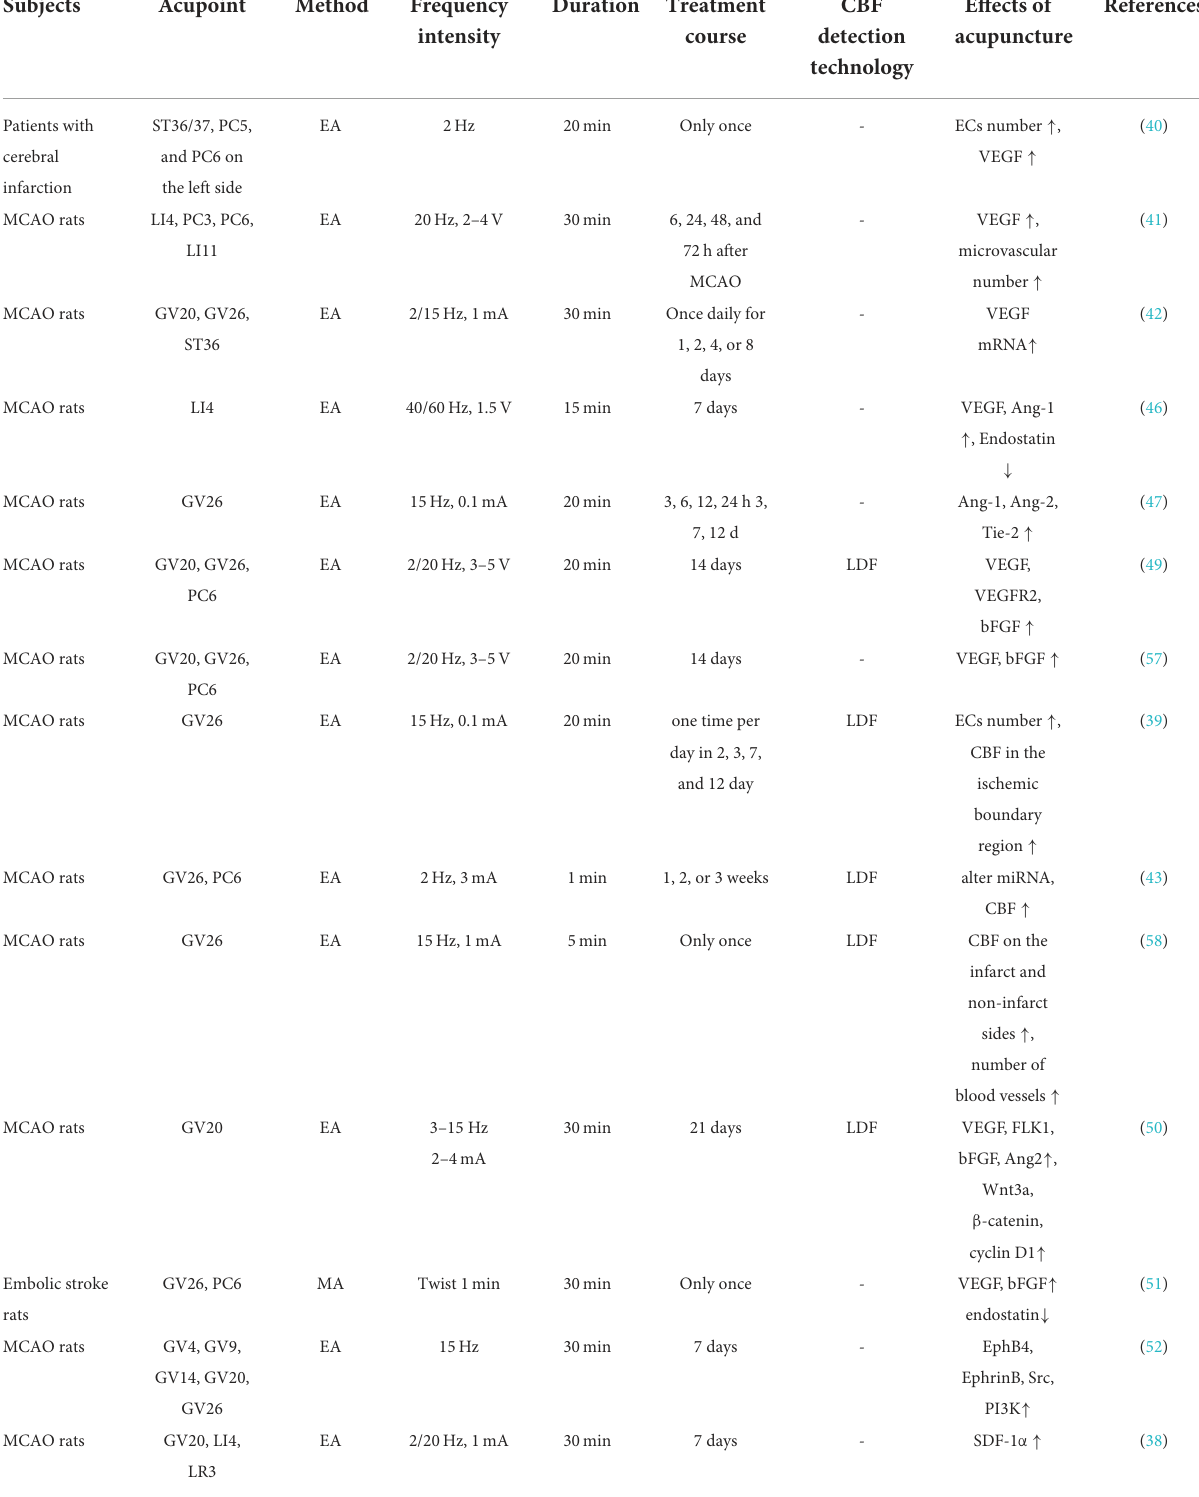
TABLE 3 Acupuncture modulates